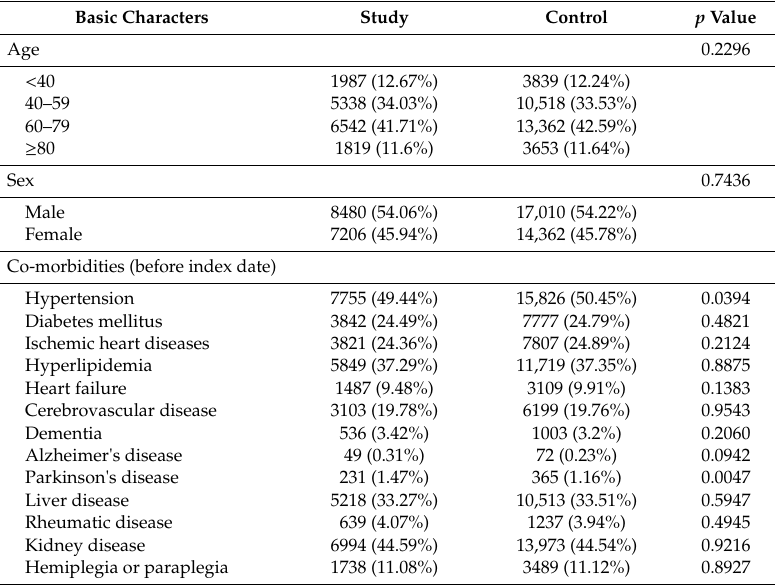
Table 1. Basic characters of the study and control groups.